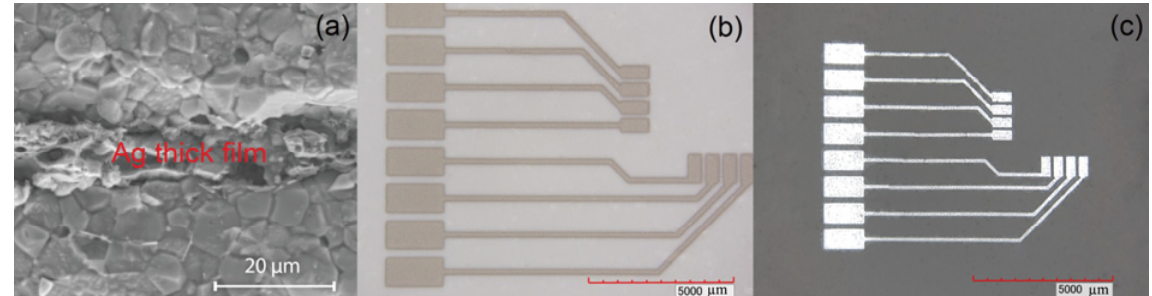
Fig. 6 (a) SEM image of the interphase between Li 2 WO 4 ceramic layer and internal Ag thick film in a ULTCC multilayer test structure co-sintered at 630 ℃ , and images from digital optical microscope of top conductor pattern cofired at 610 ℃ :